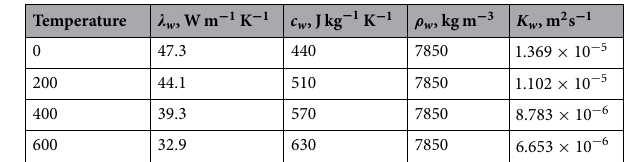
Table 6. Thermophysical properties of the wheel material made of ER7 steel 30 .